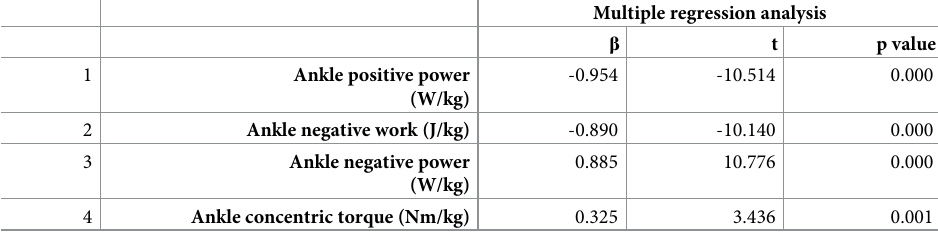
Table 4. Multiple regression analysis of predictors of contact